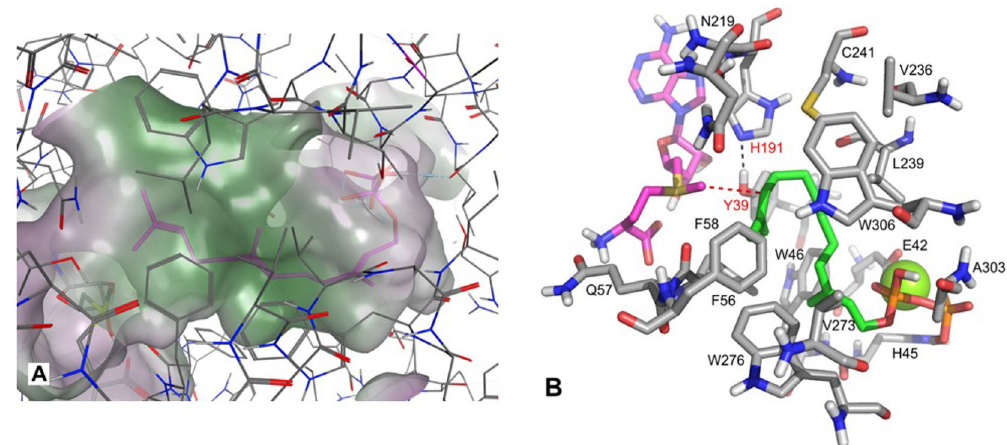
Figure 4. Binding site of FPP and stick model of the Serratia plymuthica FPP C -methyltransferase. ( A ) The binding site exhibits lipophilic potential (green area). ( B ) The starting structure of the active site was used for PM7 reaction coordinate calculations. All backbone atoms of the amino acid residues were fixed during all calculations. For better visualization, non-polar hydrogen atoms are not displayed. The substrate FPP is represented by green carbon atoms and SAM is shown in magenta. Green ball close to E42 represents Mg 2+ . Except for V236, V273, and F58, all labeled amino acid residues were experimentally mutated to alanine (Tables 1, S3), which resulted in inactivation or reduction of enzymatic